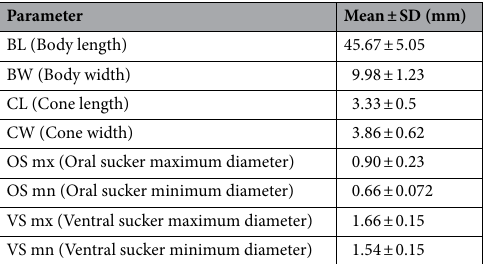
Table 2. Morphometric data of the detected adult liver flukes.